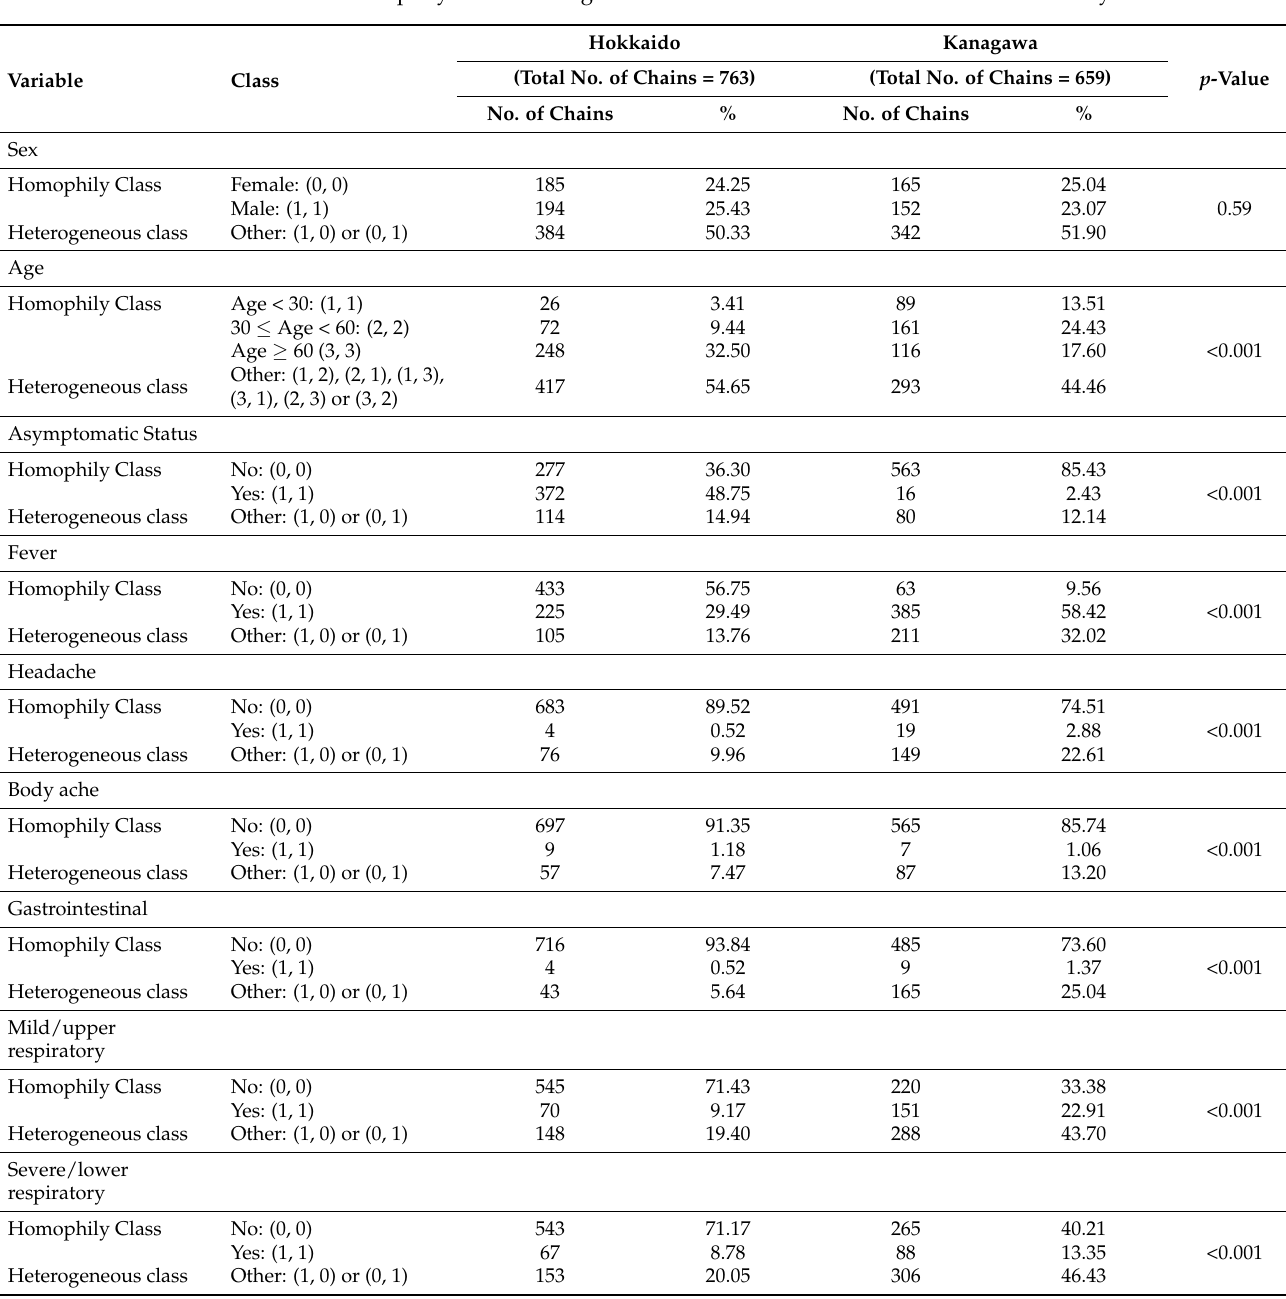
Table A1. Distributions of Homophily * and Heterogeneous ** Chains in Viral Transmission Networks by Prefecture.